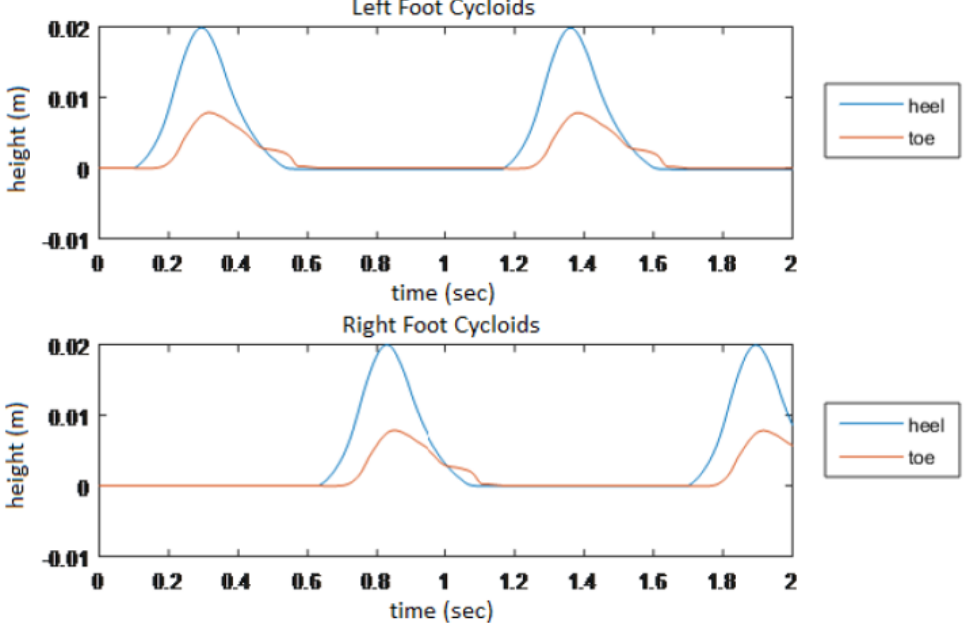
Figure 6. Feet (heel and toe) cycloids for the imposed gait parameters (speed v=0.075 m/s, gait length s=0.08 m, gait height h=0.02 m and friction coefficient µ=0.20)